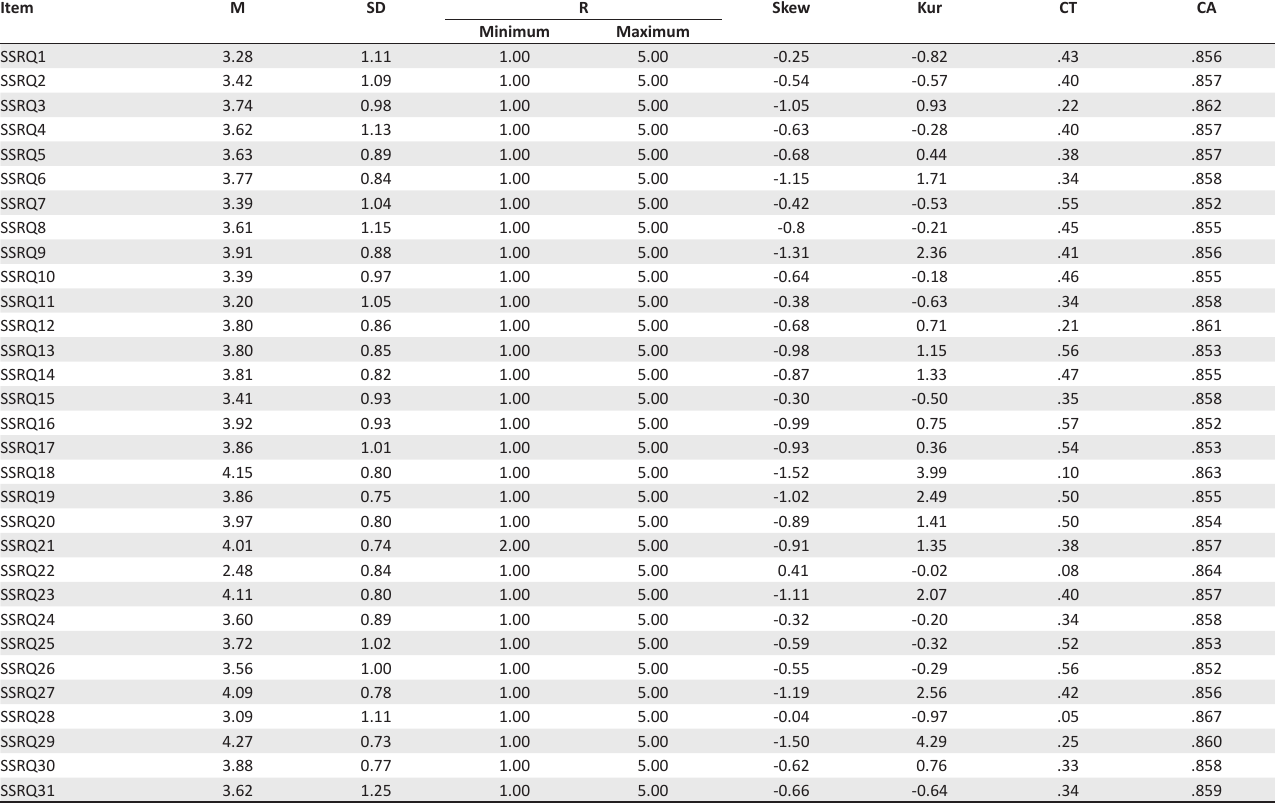
TABLE 1: Descriptive statistics and reliability indices of the Short Self-Regulation Questionnaire items. Item